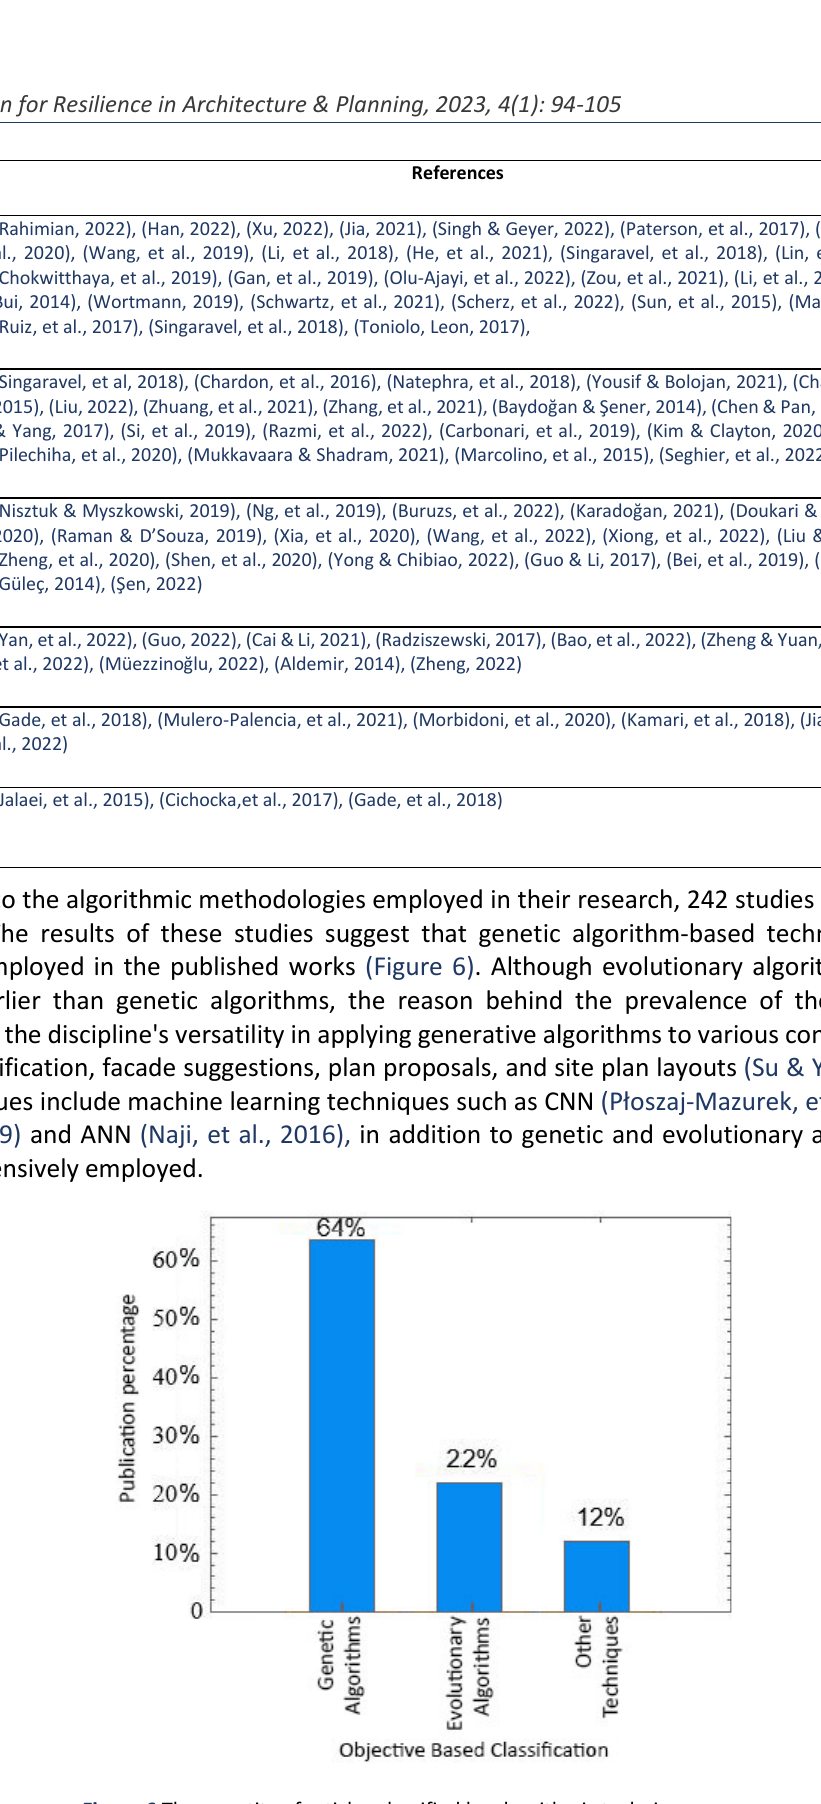
Figure 6 The quantity of articles classified by algorithmic